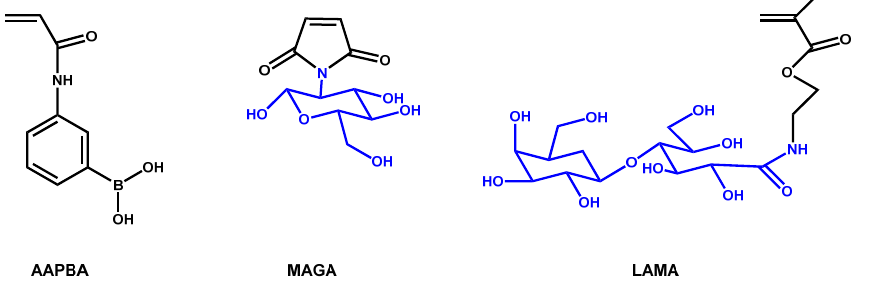
Figure 7. Different monomers used for